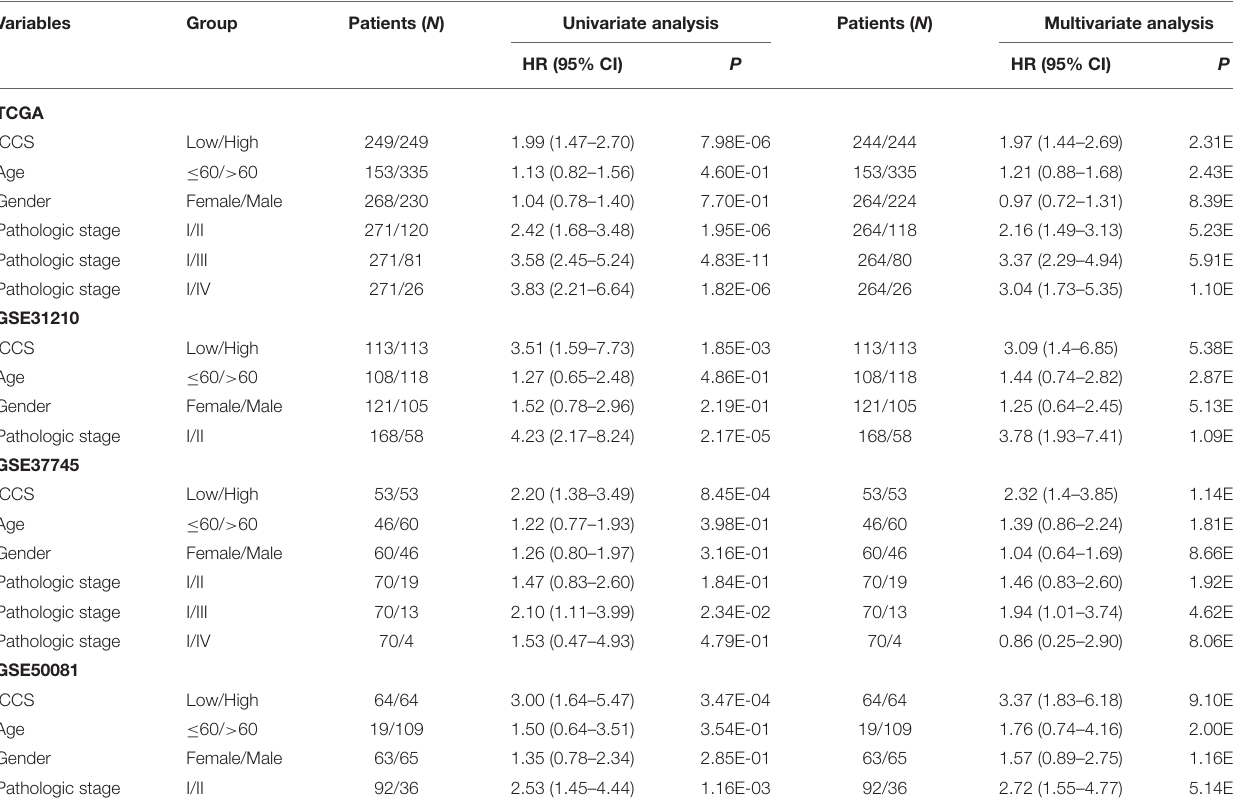
TABLE 1 | Cox regression analysis of the ICCS, clinicopathological features, and overall survival of LUAD patients. Variables Group Patients ( N ) Univariate analysis Patients ( N